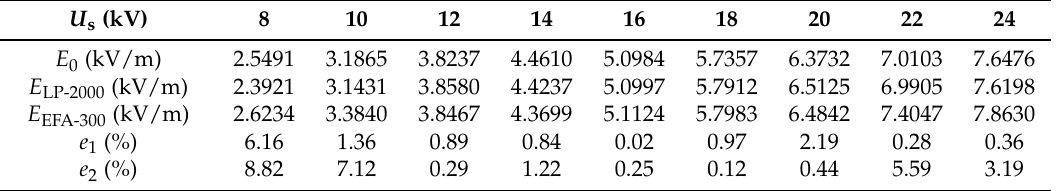
Table 5. Measurement data statistics of stimulation and experiment and error analysis (in the absence of a human